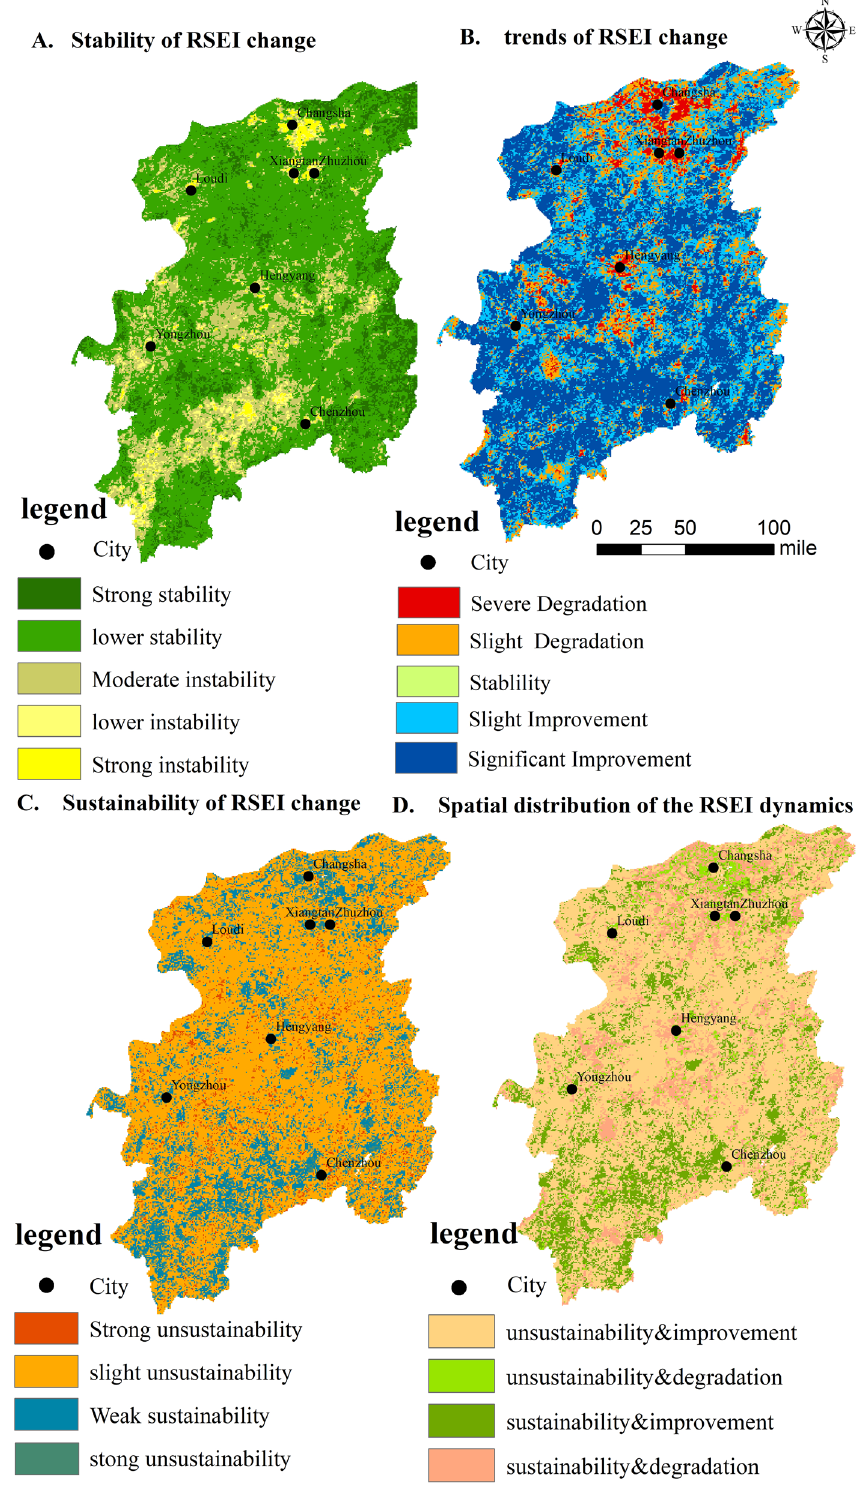
Figure 3. ( a ) Spatial distribution of the coefficient of variation of the interannual RSEI in the Xiangjiang Basin from 2001 to 2020, ( b ) trends of interannual RSEI change in the Xiangjiang Basin from 2001 to 2020, ( c ) sustainability of interannual RSEI change in the Xiangjiang Basin from 2001 to 2020, ( d ) spatial distribution of the RSEI dynamics based on trends and the Hurst